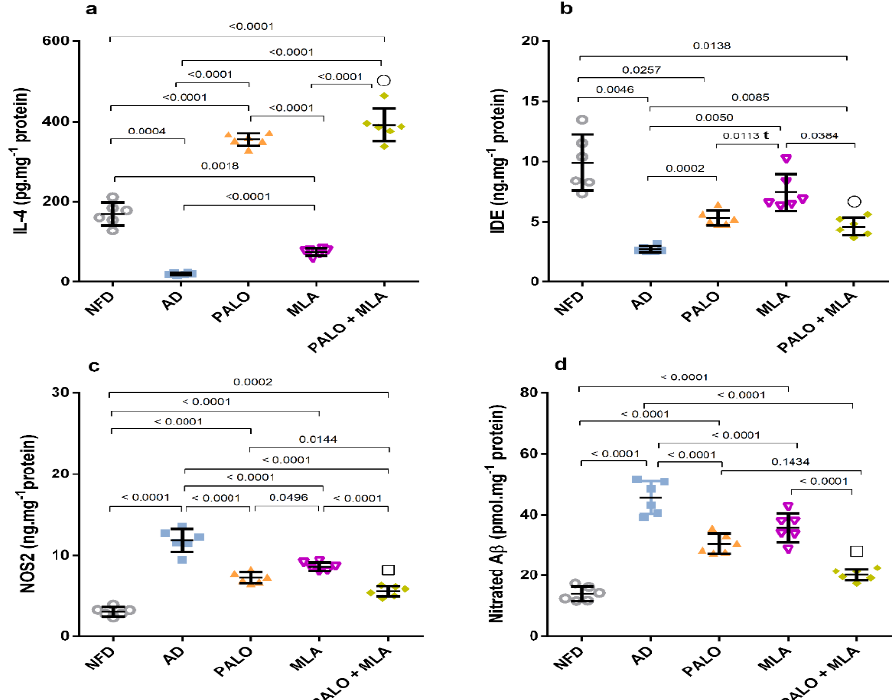
Figure 5. Effect of PALO and/or MLA on hippocampal contents of ( a ) IL-4, ( b ) IDE, ( c ) NOS2, and